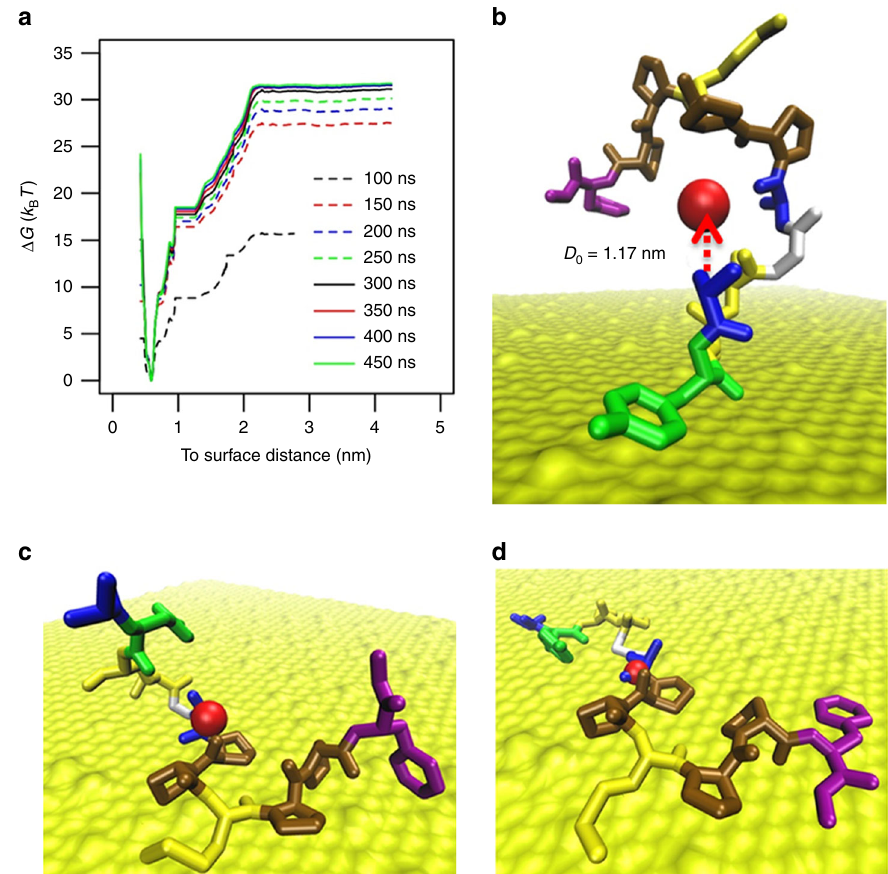
Fig. 5 Molecular dynamics simulation. a The calculated potential of mean force (PMF) using adaptive biasing force method. After 400 ns simulation, the solution converges. b Snapshot of peptide conformation in the window centered at 1.5 nm; when the distance of the mass center of all the alpha carbons of the peptide from surface is ~1.2 nm, the N-terminal touches the surface and stays for a while, which corresponds to the plateau around 1 nm shown in ( a ). c Snapshot of peptide conformation in the window centered at 0.9 nm. d Snapshot of peptide conformation in the window centered at 0.3 nm. The center- of-mass is represented by a red